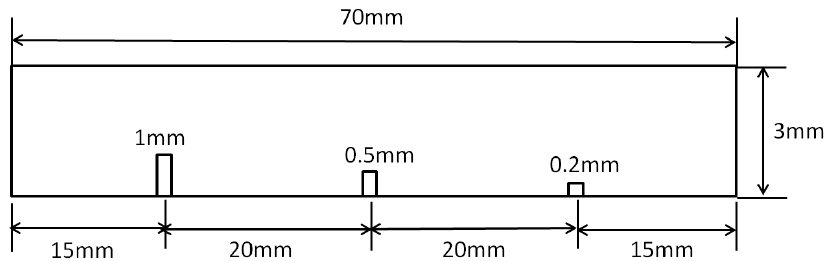
Figure 17. The sample of the aluminum plate with three artificial slits with a width of 0.2 mm and depths of 1 mm, 0.5 mm, and 0.2 mm.